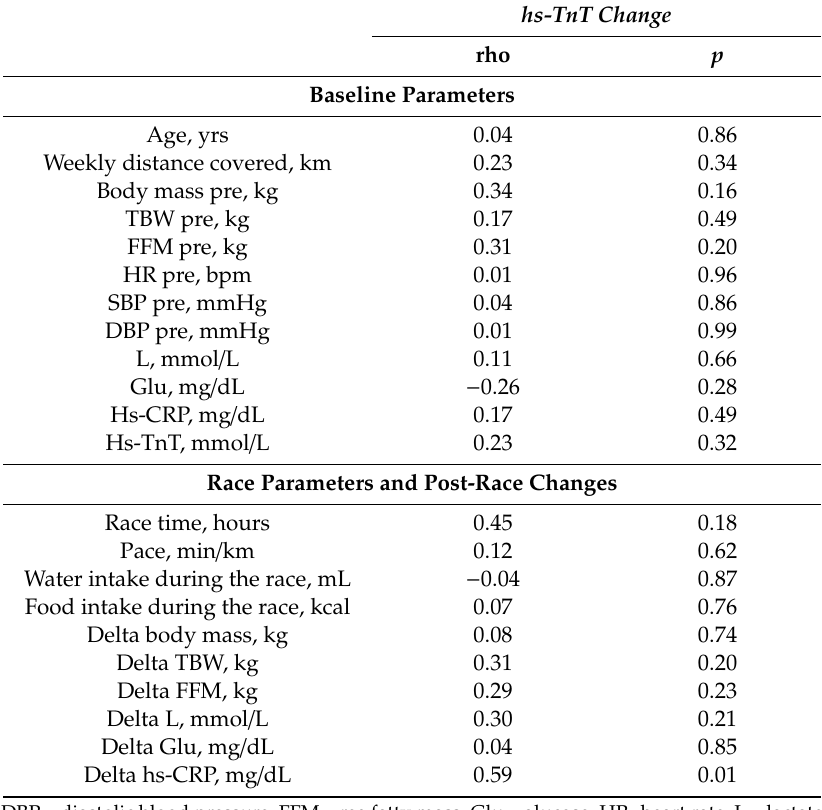
Table 3. Correlation between change in hs-TnT and analysed